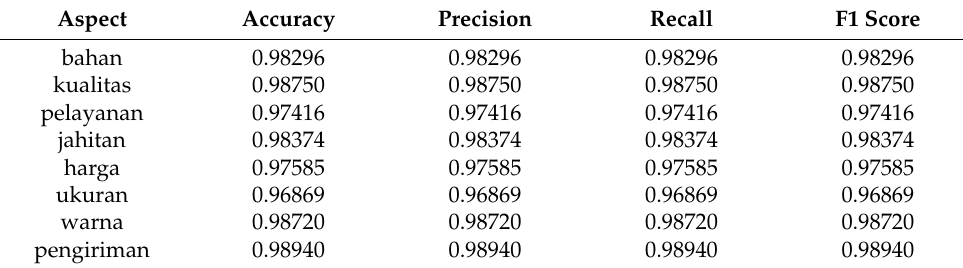
Table 7. The experiment results of the GRN model in every